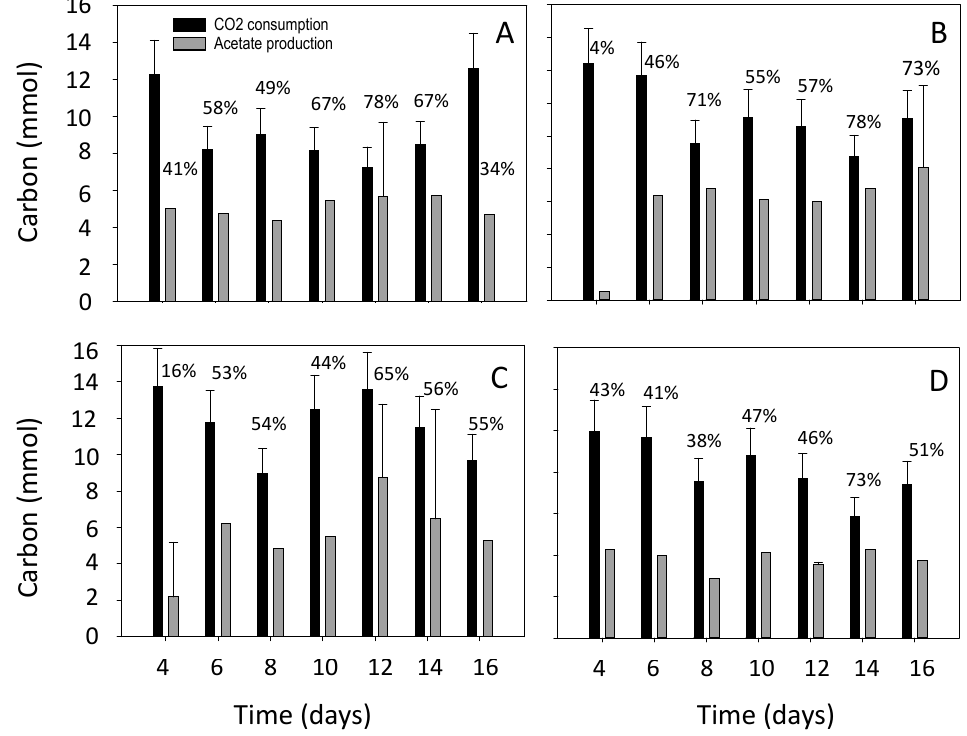
Figure 3. Carbon recovery to acetate at 0.1 mM redox mediators. The recovery was estimated from the second to eighth cycles of each replenishment. ( A ) Control, ( B ) NR, ( C ) HNQ, and ( D ) HQ. The carbon balance of the first cycle (i.e., first two days) was not included to remove the initial effects of bicarbonate in the medium.